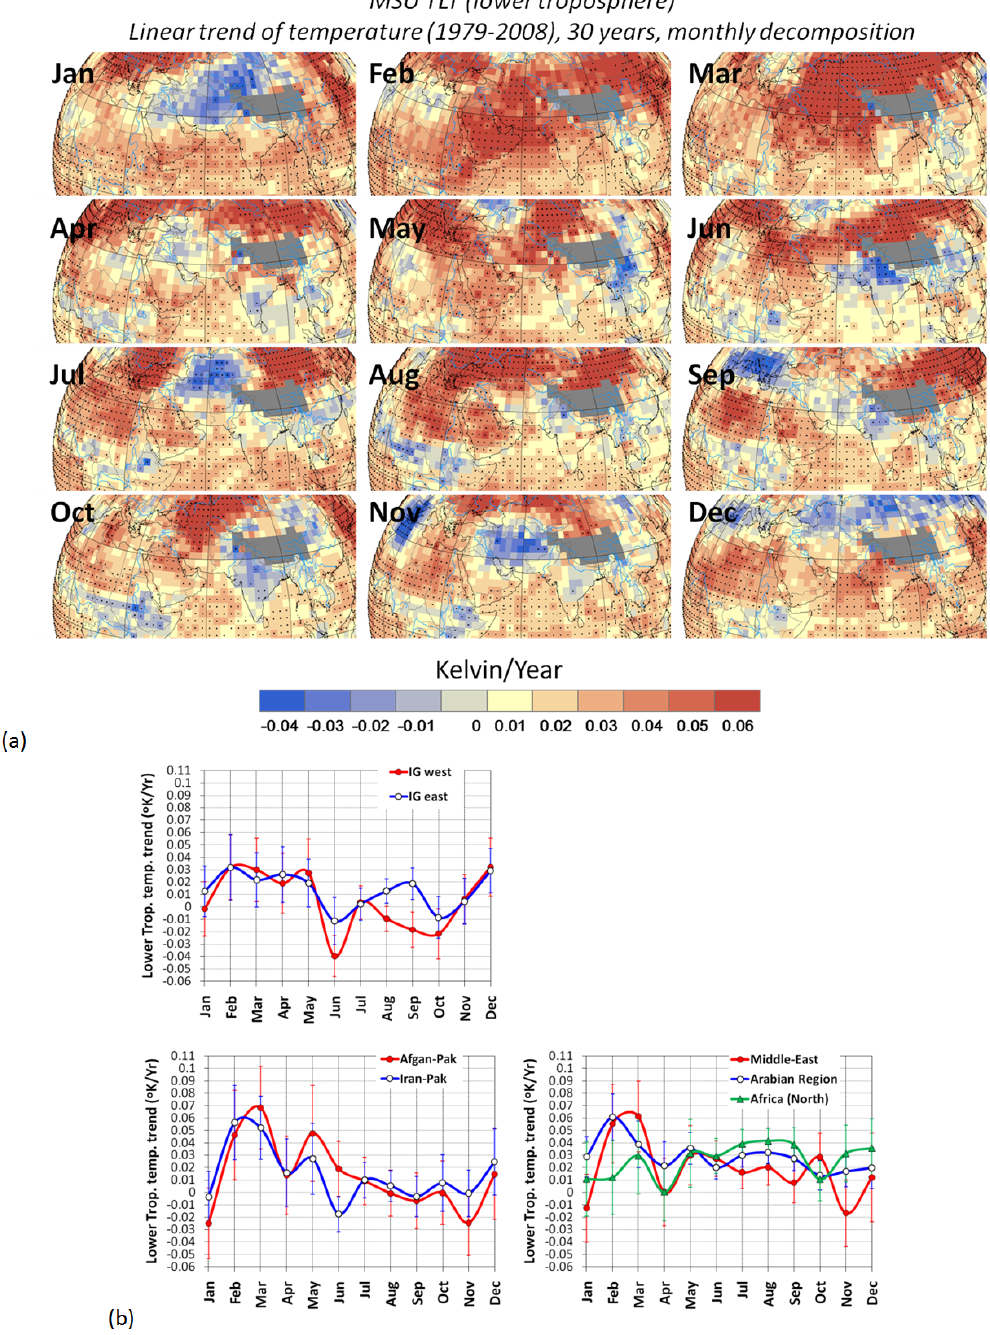
Fig. 4. The month-to-month linear trend ( ◦ Kelvin/year) of brightness temperature based on 30 years (1979–2008) of MSU TLT anomaly data. The month-to-month linear trend is shown over (a) map, and (b) specific study regions (mean trend with standard error) (Fig. 1b). The black dot at the center of any box (a) represent that the calculated linear trend value is statistically significant at alpha 0.05 (95% CI).